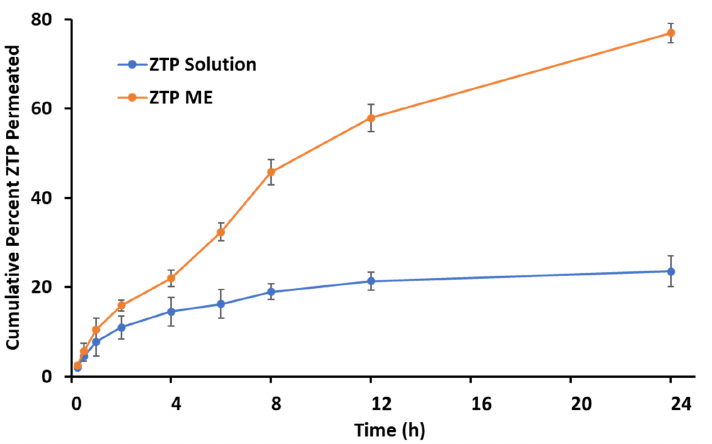
Figure 4. Ex vivo permeation of ZTP-ME and ZTP solution across porcine nasal mucosa (mean ± SD, n = 3).